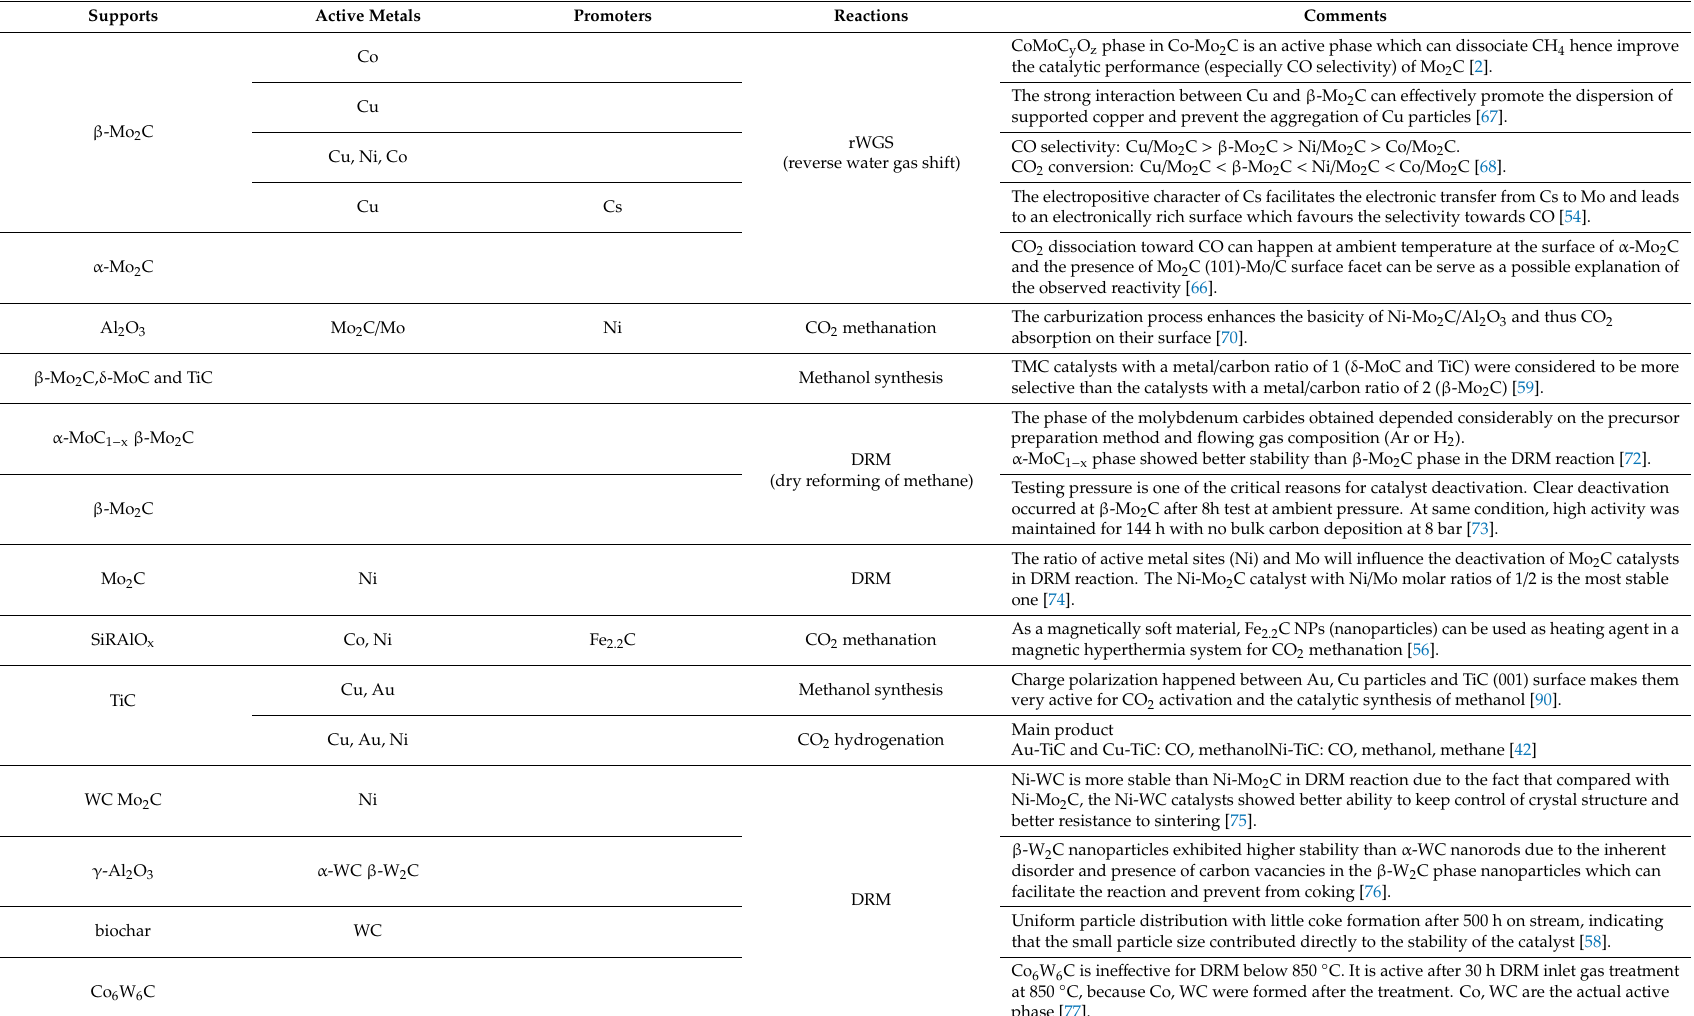
Table 3. Summary of CO 2 utilization process using di ff erent transition metal carbide (TMC)